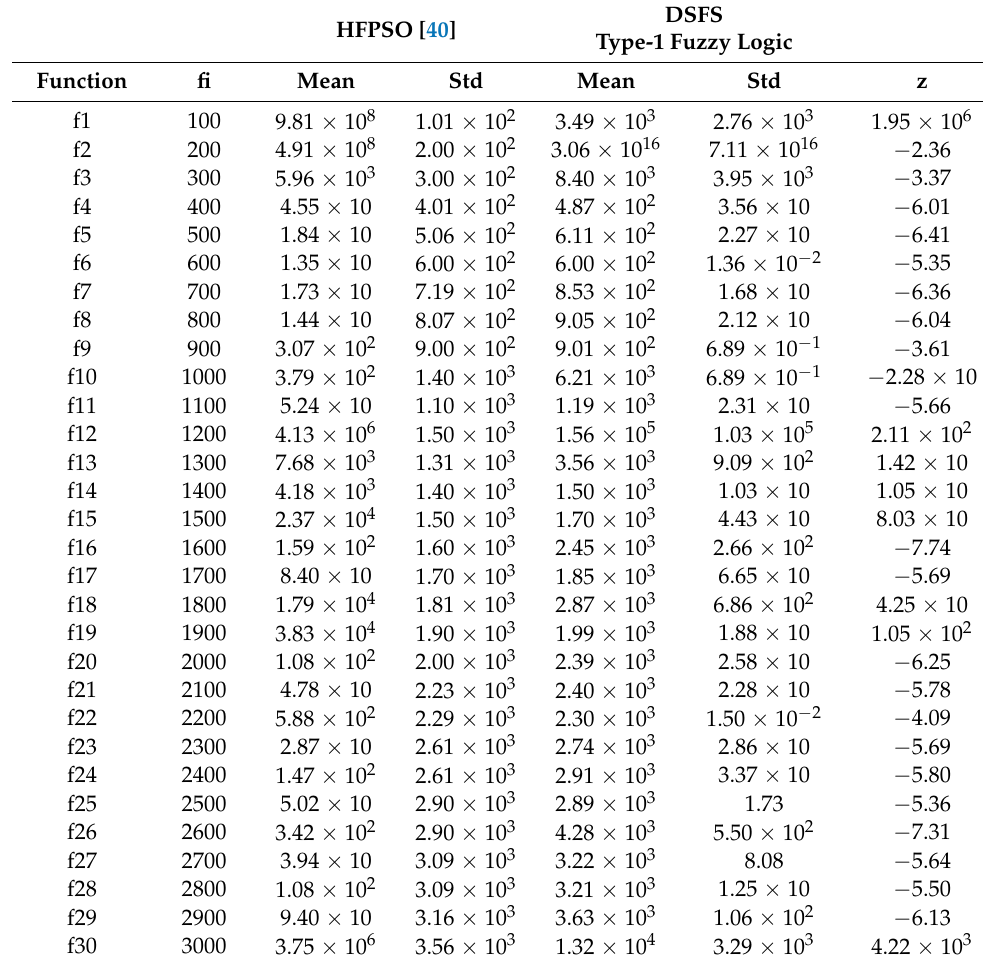
Table 9. Results Z-test for 30